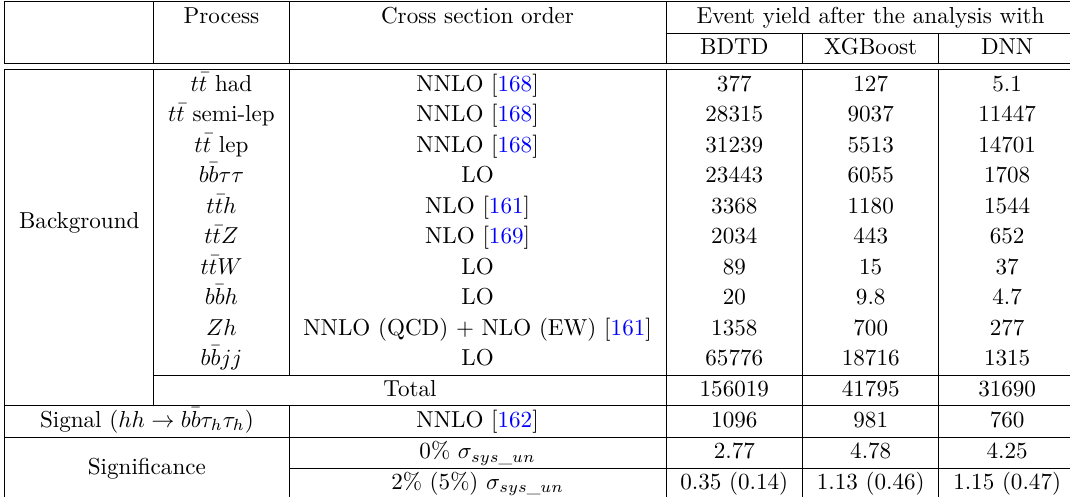
, m T,τ and m vis for the b ¯ bτ h τ h signal and the τ h τ h hh h τ h